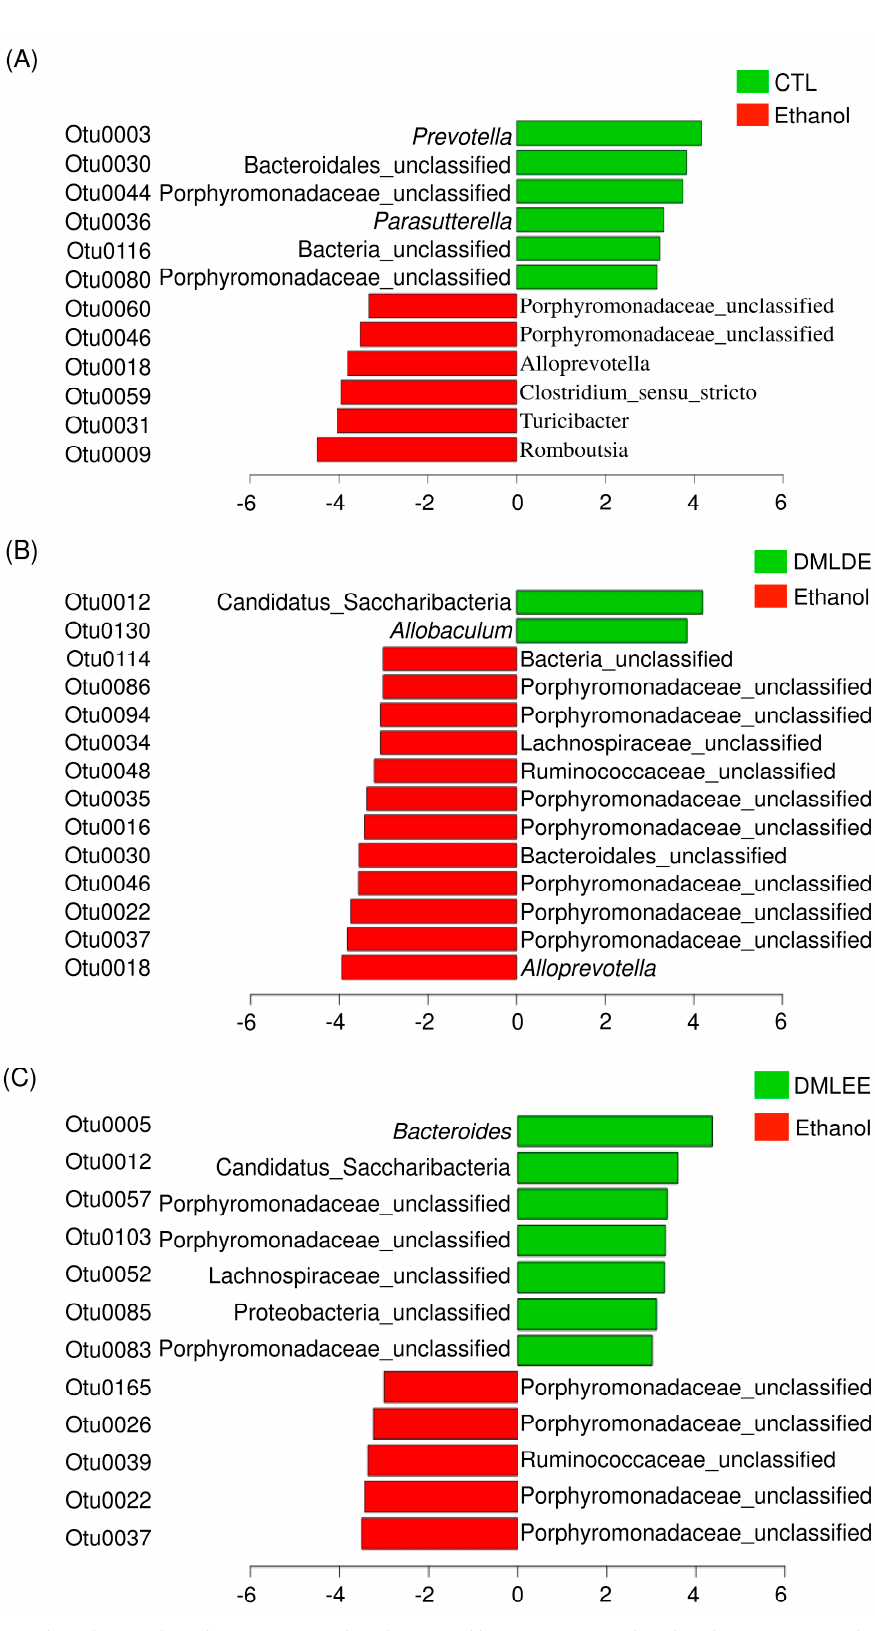
Figure6. TherelativeabundanceincreasedordecreasedbacteriainOTUlevelinthecomparisonbetween ethanol and CTL or DML extracts. Abundance analysis was performed using linear discriminant analysis e ff ect size (LEfSe). ( A ) Ethanol v / s CTL, ( B ) ethanol v / s DMLDE, ( C ) ethanol v / s